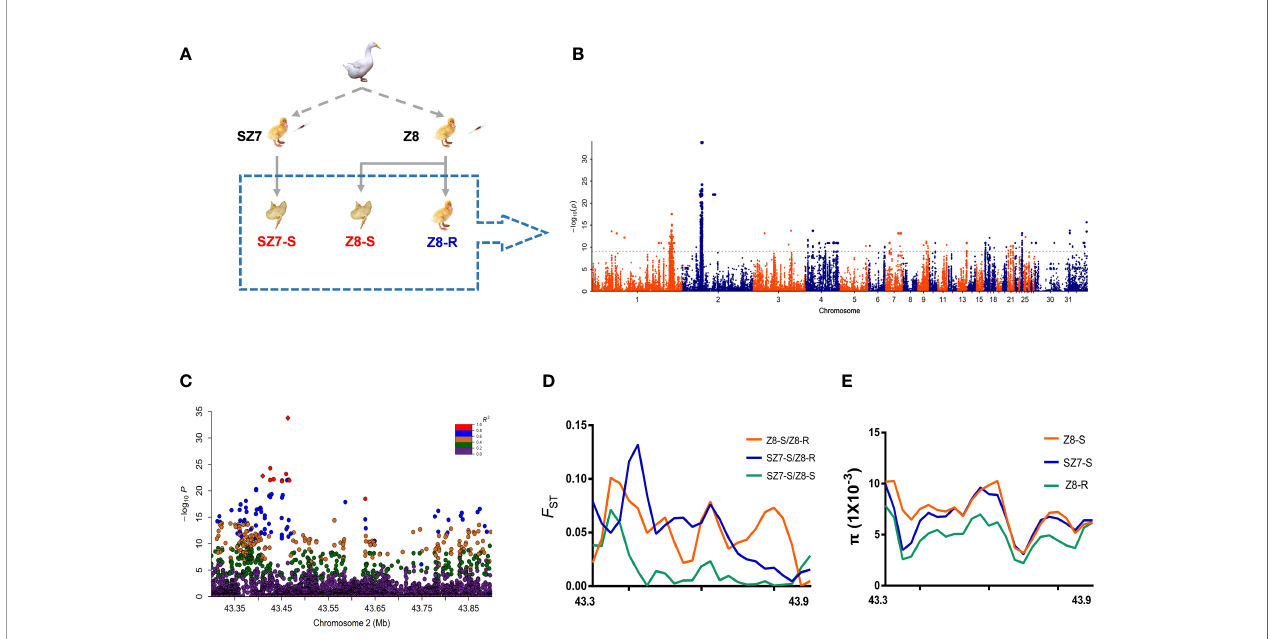
FIGURE 2 | Analysis of genetic variation related to the susceptibility trait. (A) Images are from individuals of fl ock Z8 and fl ock SZ7. The dashed box shows the selection of animal materials used in this study for resequencing. (B) Manhattan plot showing the genetic effects on the susceptibility trait (observation color grade value) determined by GWAS in 110 Pekin ducks. The gray line represents the Bonferroni-corrected signi fi cance threshold (-log 10 P = 9.20). (C) Regional plots of the loci ranging from 43.30 to 43.90 Mb along chromosome 2 associated with the susceptibility trait. All genotyped SNPs are color coded according to their pairwise linkage disequilibrium (LD) with the leader SNP (Chr2:43,445,923) calculated in the Pekin ducks. (D) Selective sweeps among three duck populations within the candidate region (Chr2:43.30-43.90 Mb). (E) The nucleotide diversity ( p ) of SZ7-S (blue line), Z8-R (green line) and Z8-S (red line) from 43.30 to 43.90 Mb on chromosome